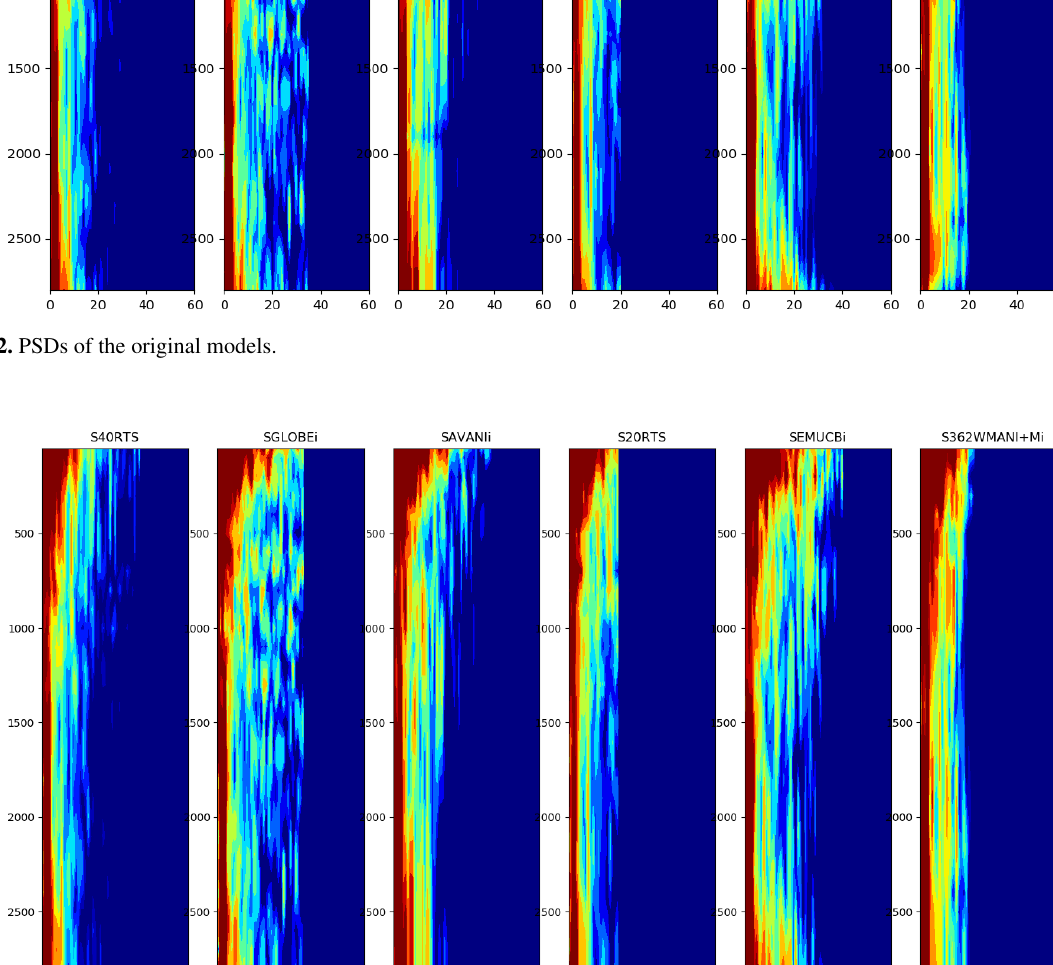
Figure B3. PSDs of the reconstructed models from the varimax modes. The number of modes is given in Table 2.